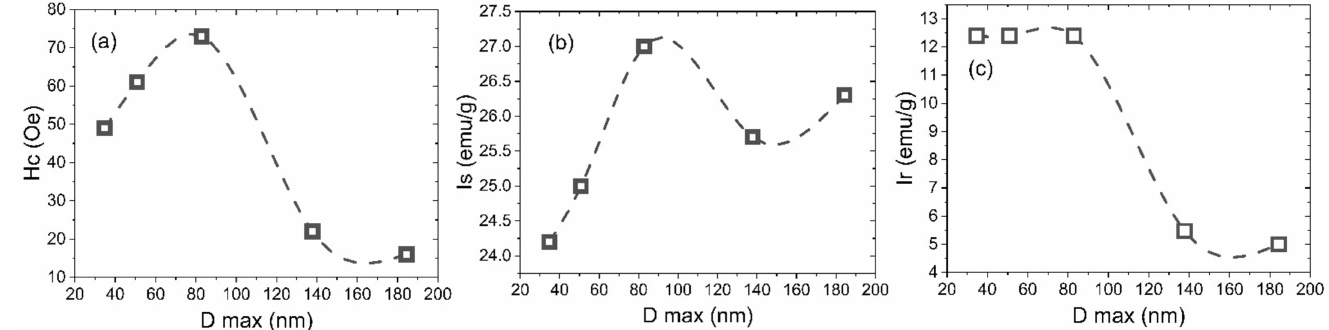
Figure 8. Particle size dependencies on coercivity ( a ), saturation magnetization ( b ), and remnant magnetization ( c ) at room